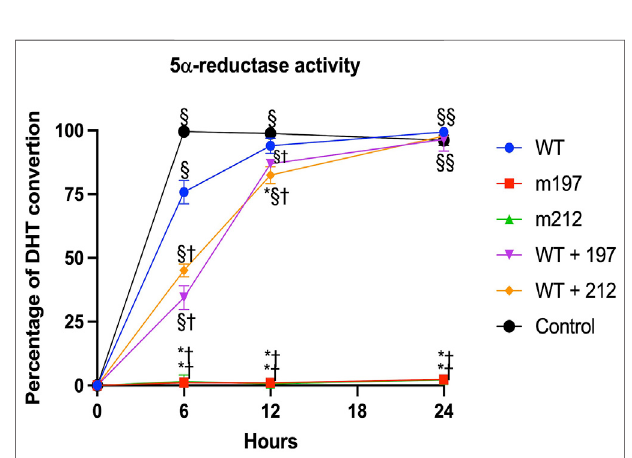
FIGURE 3 | Steriod 5 α -reductase 2 activity expressed in HEK293 cells. Saturationcurvesofmutantsweredeterminedbymeasuringtheconversionof T [1, 2, 6, 7-3H(N)] to DHT with increasing concentrations of unlabeled T (0.125 – 8.0 mmil/L). All experiments were performed in triplicate. p < 0.05 * vs. WT; † vs. Control; § vs. m197,